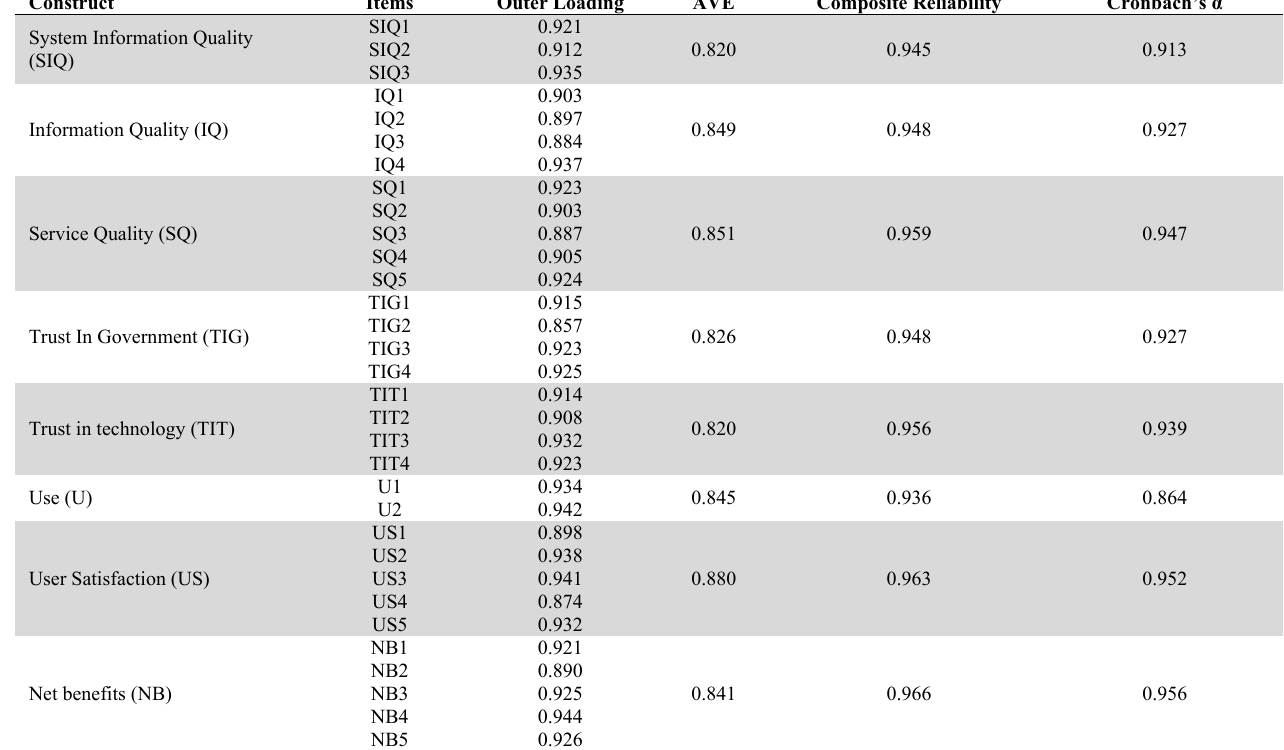
Outer Model Evaluation